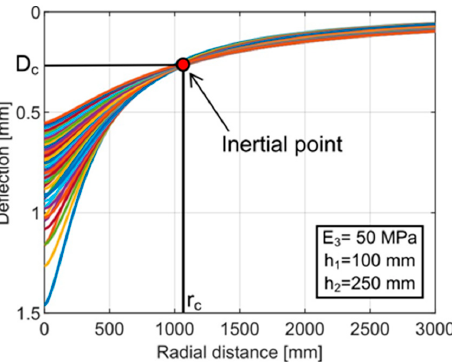
Figure 11. Inertial point in the three-layer pavement system (72 pavement cases).